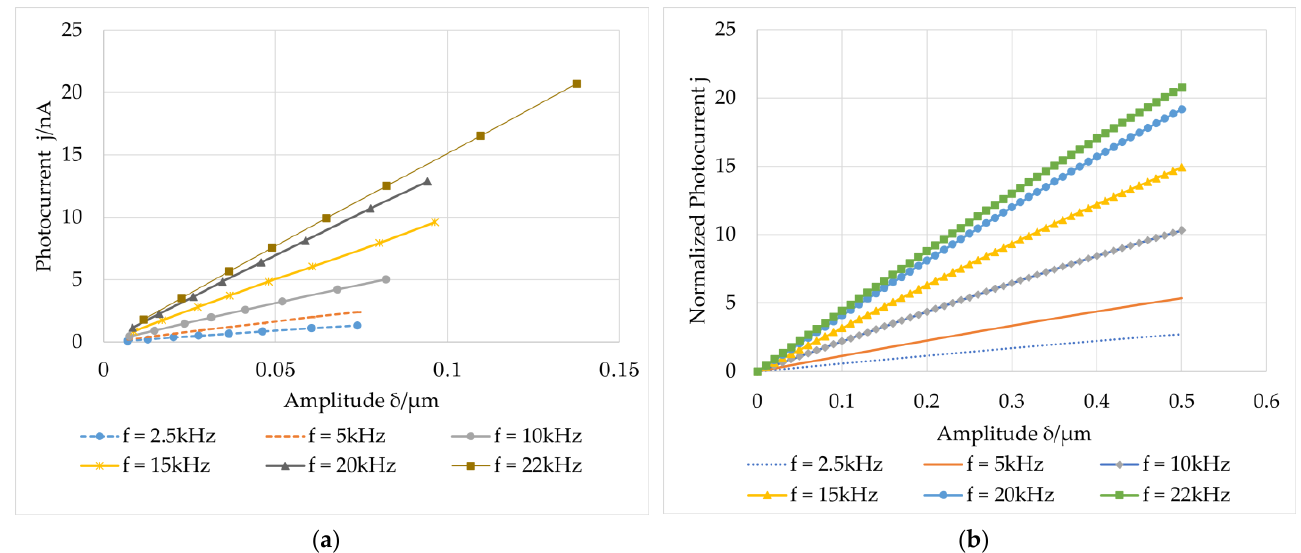
Figure 6. Relation between amplitude of the first harmonic of the photocurrent and amplitude of the vibration at different vibration frequencies: ( a ) experimental results; ( b ) theoretical simulation results.